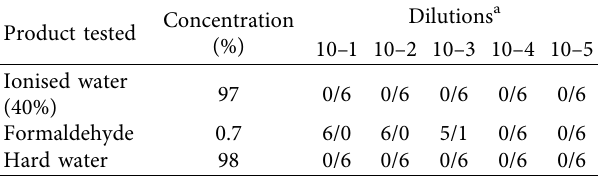
Table 1: Cytotoxicity of products on VERO-81 cells.